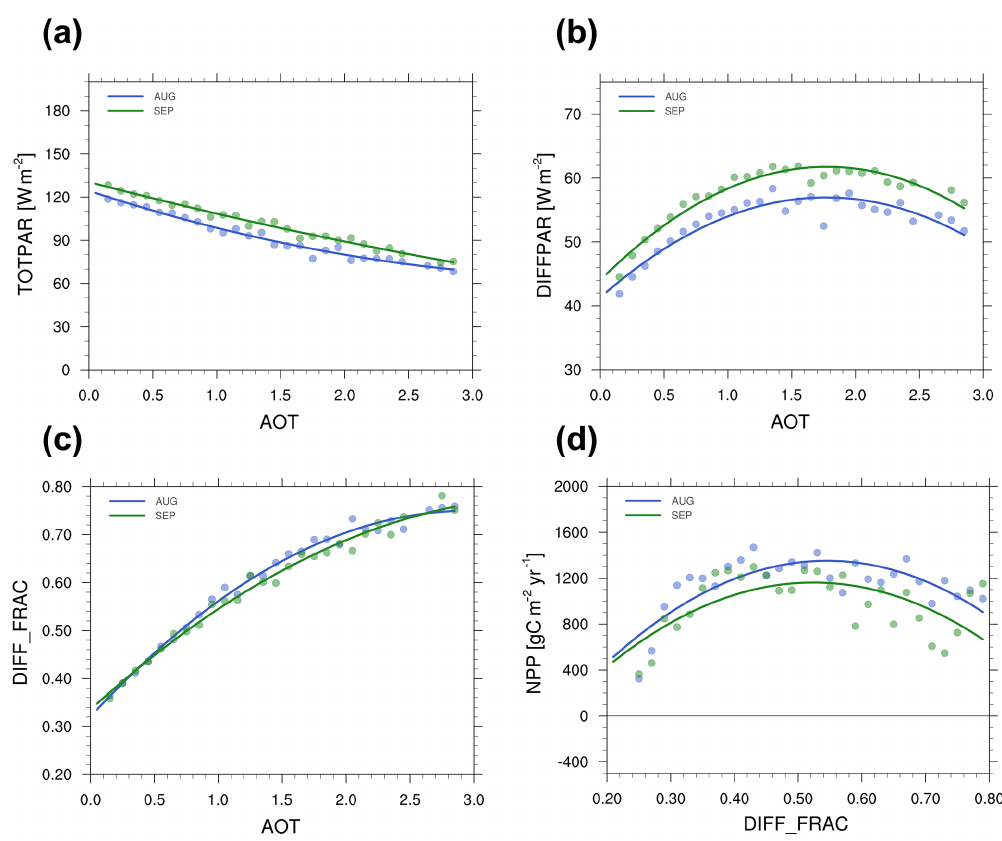
Figure 4. Showing the total PAR (TOTPAR, a ), the diffuse PAR (DIFFPAR, b ) and the fraction of PAR that is diffused (DIFF_FRAC, c ) reaching the surface versus the total aerosol optical thickness (AOT) at 550nm and the net primary productivity (NPP, d ) against the fraction of PAR that is diffused. Circles represent the binned data from the HadGEM2-ES simulations, while plain lines are the corresponding second- order polynomial fits. Prior to binning, data were first collected at all grid cells in the Amazon region (i.e. the red box region in Fig. 2) for all five BBA emission experiments. We then aggregate all grid cells into 30 AOT bins ranging from 0 to 3 at an interval of 0.1. In each bin, we calculate average AOT and corresponding TOTPAR, DIFFPAR and DIFF_FRAC (Fig. 4a, b and c, respectively; we calculate average DIFF_FRAC and corresponding NPP in Fig.